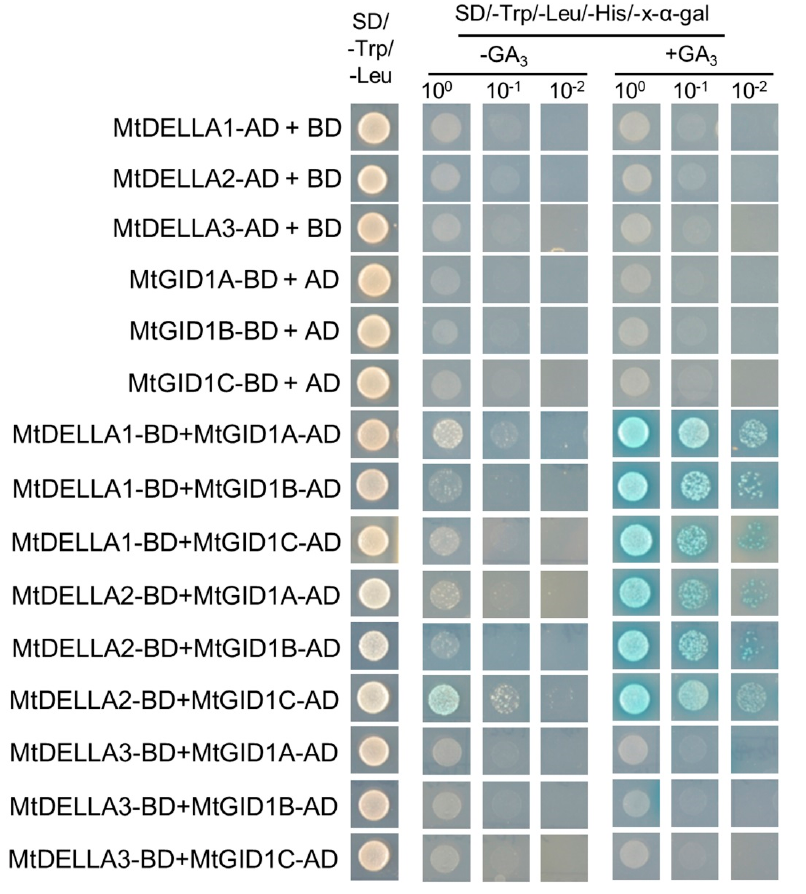
Figure 7. Interaction tests between MtDELLA and MtGID1 proteins in the yeast two-hybrid system. Yeast transformants are spotted onto the control medium (SD / -Leu / -Trp) and selective medium (SD/-Leu/-Trp/-His/-Ade). The initial concentration of the yeast cells spots on SD / -Trp / -Leu (panel 1) and SD/-Trp/-Leu/-His/-Ade medium (panels 2 and 5) were OD600 = 0.2. Then, the yeast cells were diluted 10 and 100 times and were plated onto selective medium (panels 3, 4, 6 and 7) containing 20 μ g/mL X- α -gal with or without GA 3 (10 − 5 M).